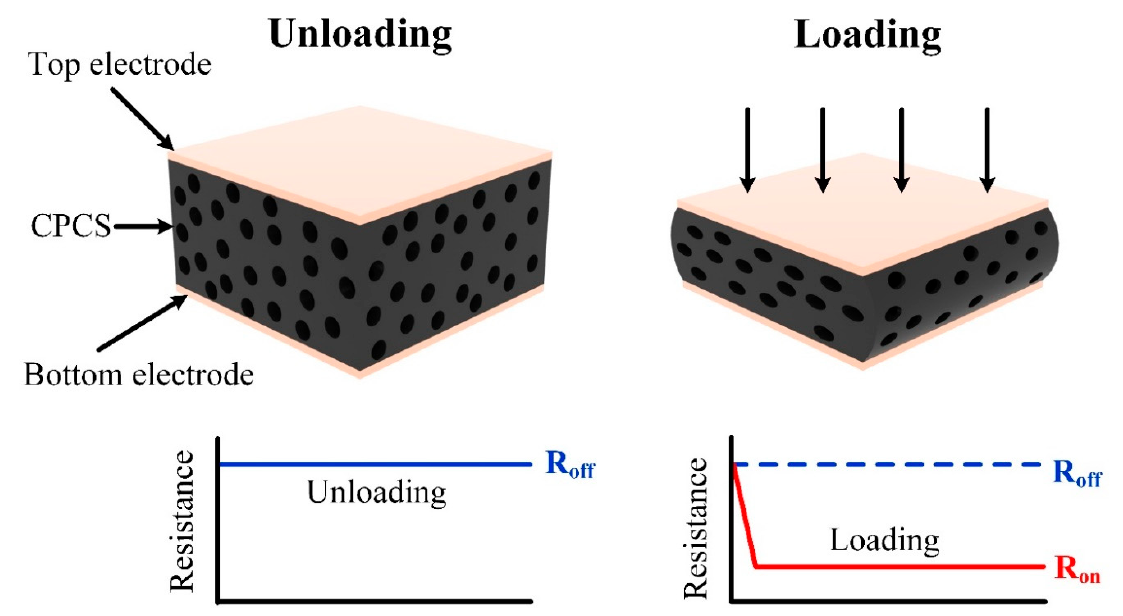
Figure 2. Working principle of the proposed pressure sensor. The resistance between the two electrodes changes with the applied pressure because of the increased conductive pathways.